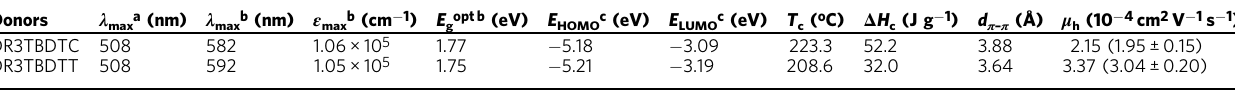
The hole mobility data in parentheses are the statistical average and error bars of standard deviation calculated from 16 individual devices and data outside of parentheses are the best results a CB solution b Thin fi lms spin-coated from CB solution c Cyclic voltammetry carried out on the as-cast thin fi lms and the energy levels estimated by the equation of E HOMO/LUMO = − (4.80 + E onset ox / E onset red )eV